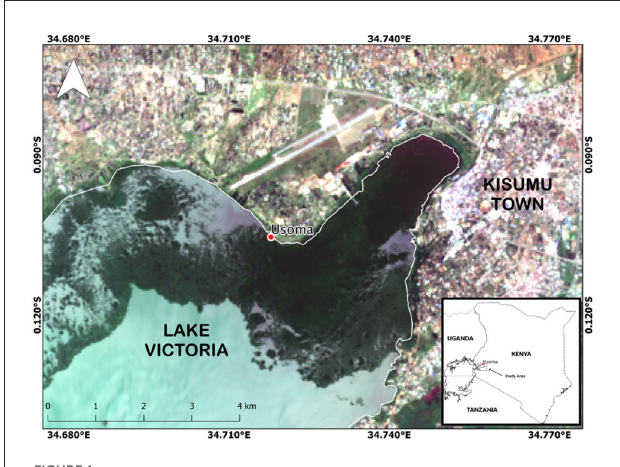
FIGURE1 Map of field site location within Winam Gulf, Lake Victoria.